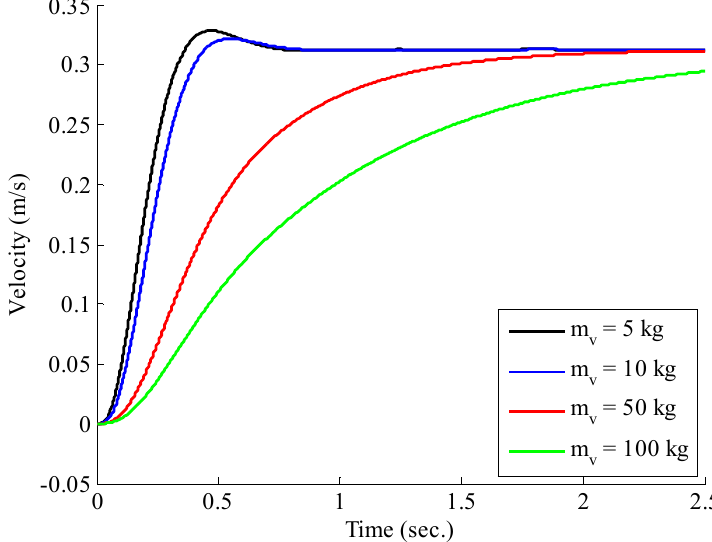
Figure 16. Response of the seat velocity for a varying virtual mass m v , c v = 120 Ns/m, T = 0.08 s, K p = 50.